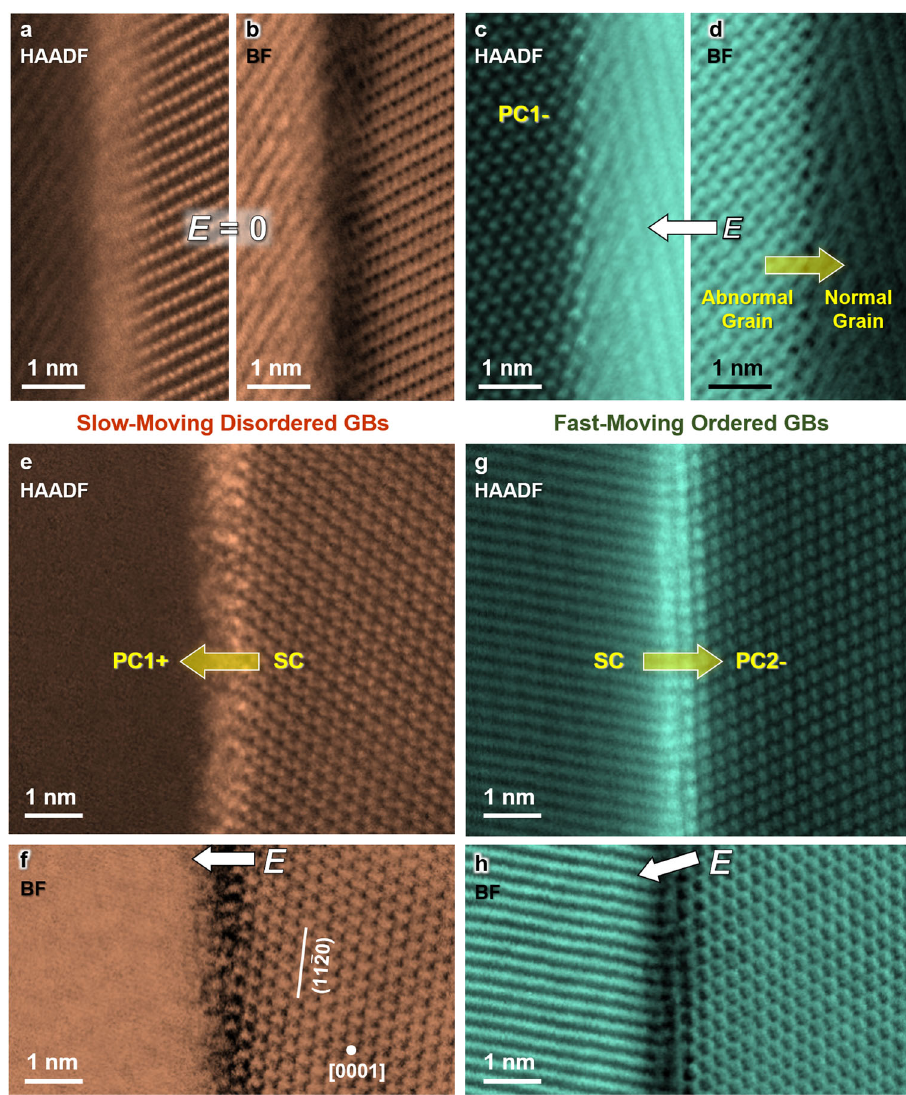
Fig. 1 AC STEM high-angle annular dark- fi eld (HAADF) and bright- fi eld (BF) images of representative slow-moving disordered vs. fast-moving ordered GBs. a , b A nanoscale amorphous-like IGF (a.k.a. disordered GB) observed in a reference specimen annealed without an electric fi eld, which is characteristic of all general GBs in Bi 2 O 3 -saturated ZnO 29 . STEM images of c , d an ordered GB of an abnormal grain in the electrochemically reduced PC1 – region, as well as e , f a slow-moving disordered GB at the oxidized PC1 + /SC interface vs. g , h a fast-moving ordered GB at the reduced SC/PC2 – interface in a PC1/SC/PC2 sandwich specimen annealed with an applied electric current (as schematically shown in Fig. 2a). STEM images for additional examples can be found in Supplementary Figs. 9 – 12, showing the generality of the observations of slow-moving disordered GBs vs. fast-moving ordered